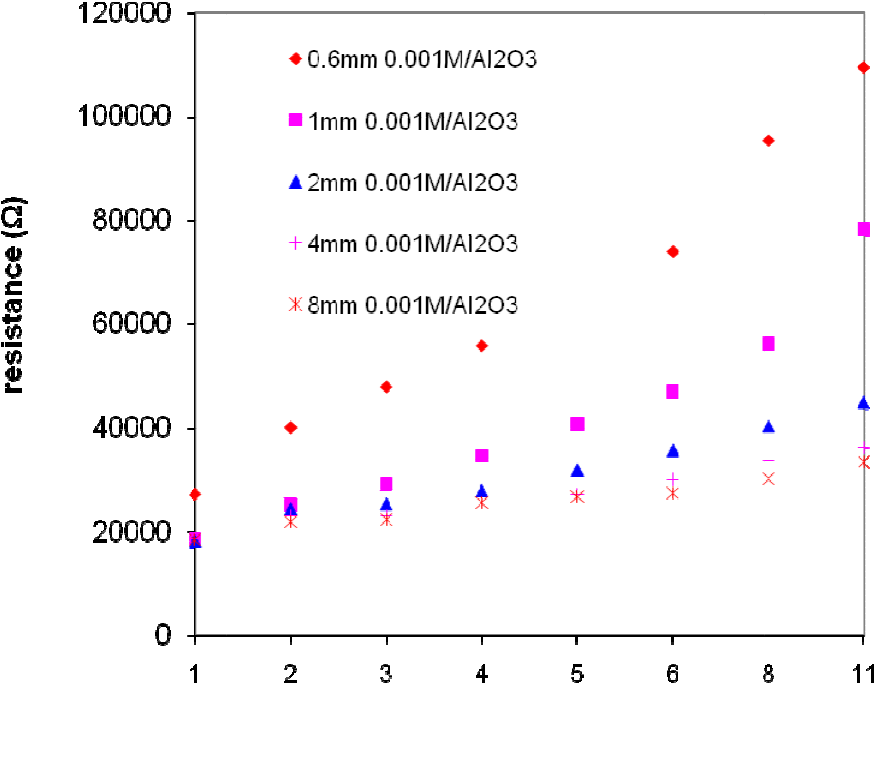
Figure 5. Solution resistance as a function of electrode distance (a): resistance increases with the increase in electrode distances and solution thickness (b): resistance decreases with the increase in solution thicknesses.